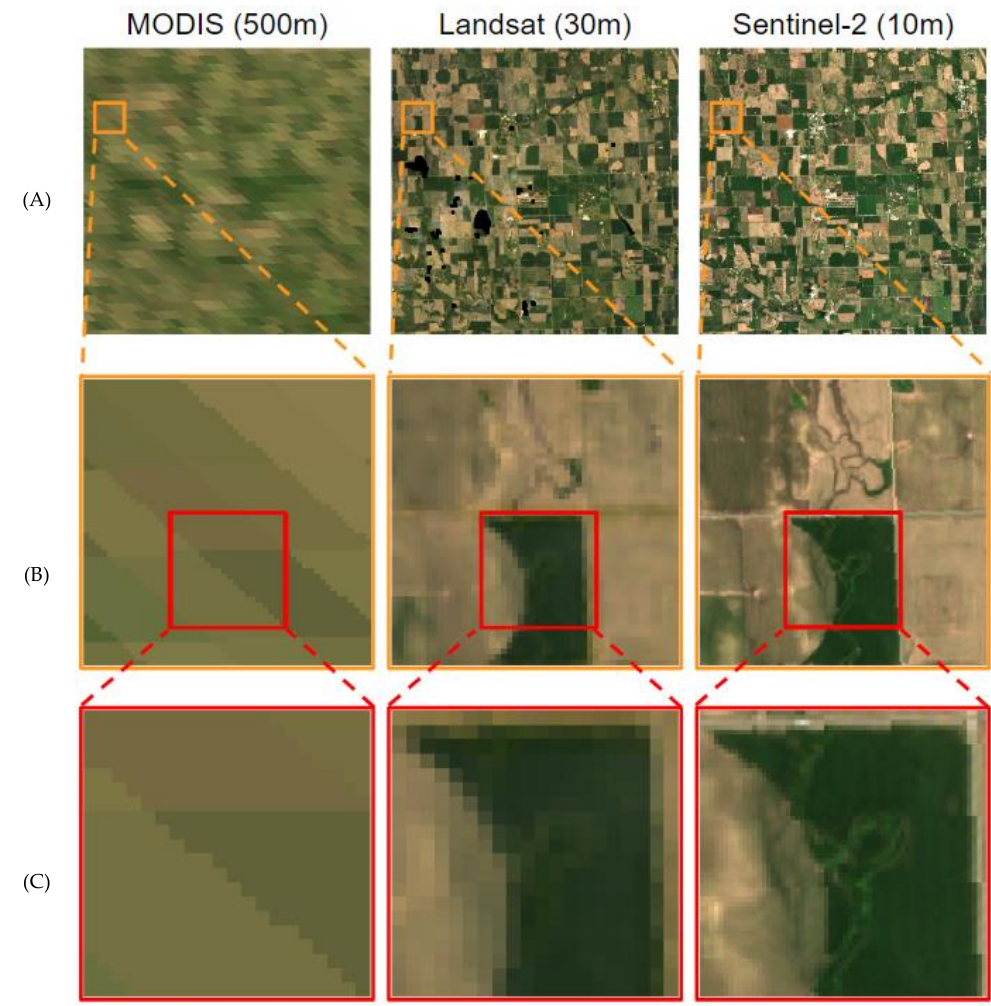
Figure 2. Example visualization of MODIS, Landsat, and Sentinel-2 images: ( A ) three temporarily close images of MODIS (June 30, 2017), Landsat (June 30, 2017), and Sentinel-2 (June 29, 2017) dataset are selected and the RGB composite images are displayed for a sub-region of Saunders, NE; and ( B , C ) two levels of zoom-in views of the selected region.